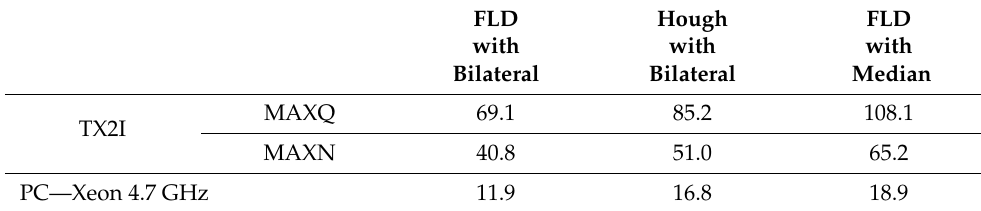
Table 6. Final computing times comparison, in ms . FLD Hough FLD with with with Median Bilateral Bilateral MAXQ 69.1 85.2 108.1 TX2I MAXN 40.8 51.0 65.2 PC—Xeon 4.7 GHz 11.9 16.8